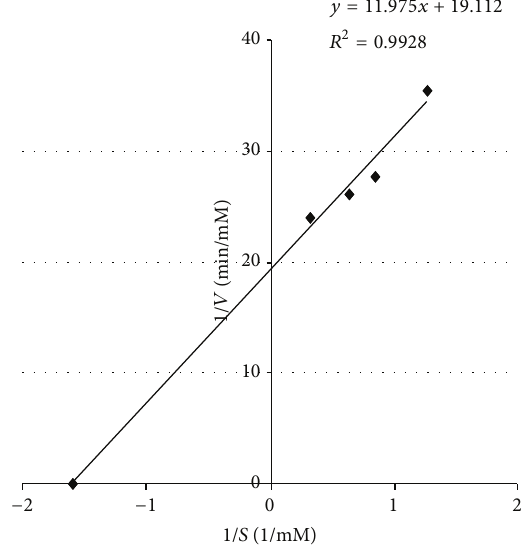
Figure 1: Kinetic constants of protease enzyme production (the Lineweaver-Burk plot).